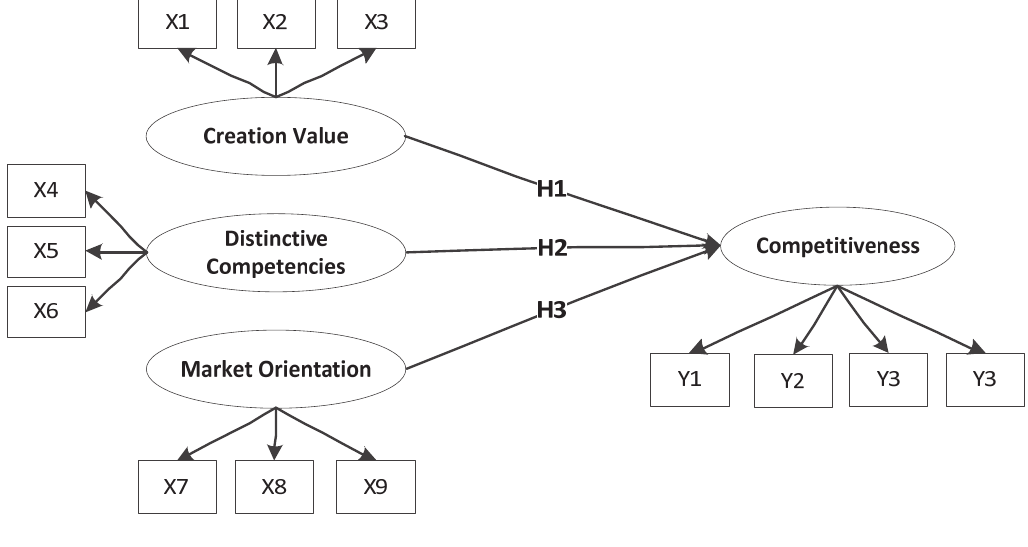
Fig. 1. Research Hypothesis